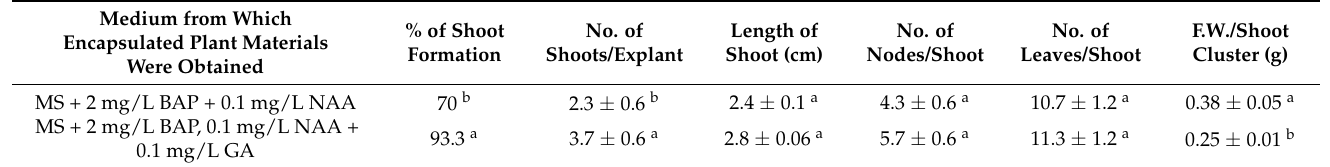
Table 7. Effect of presence or absence of GA in plant materials medium on conversion of conserved (for one month at 4 ◦ C) paulownia synseeds on semisolid MS medium containing 2 mg/L BAP and 0.1 mg/L NAA for one month.